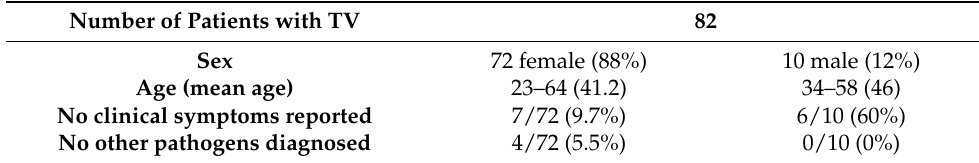
Table 1. Characteristics of the study